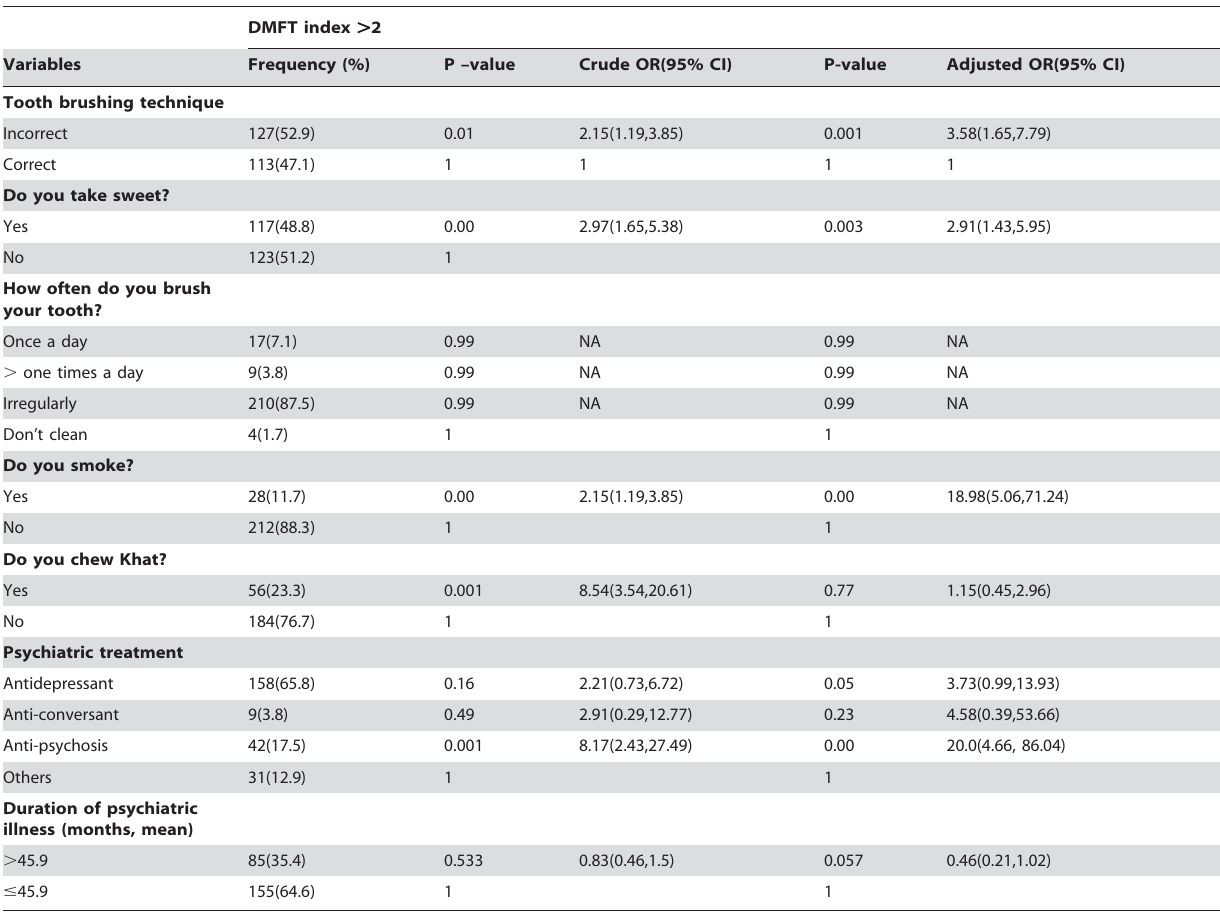
Table 3. Factors associated with mean DMFT index for periodontal disease.